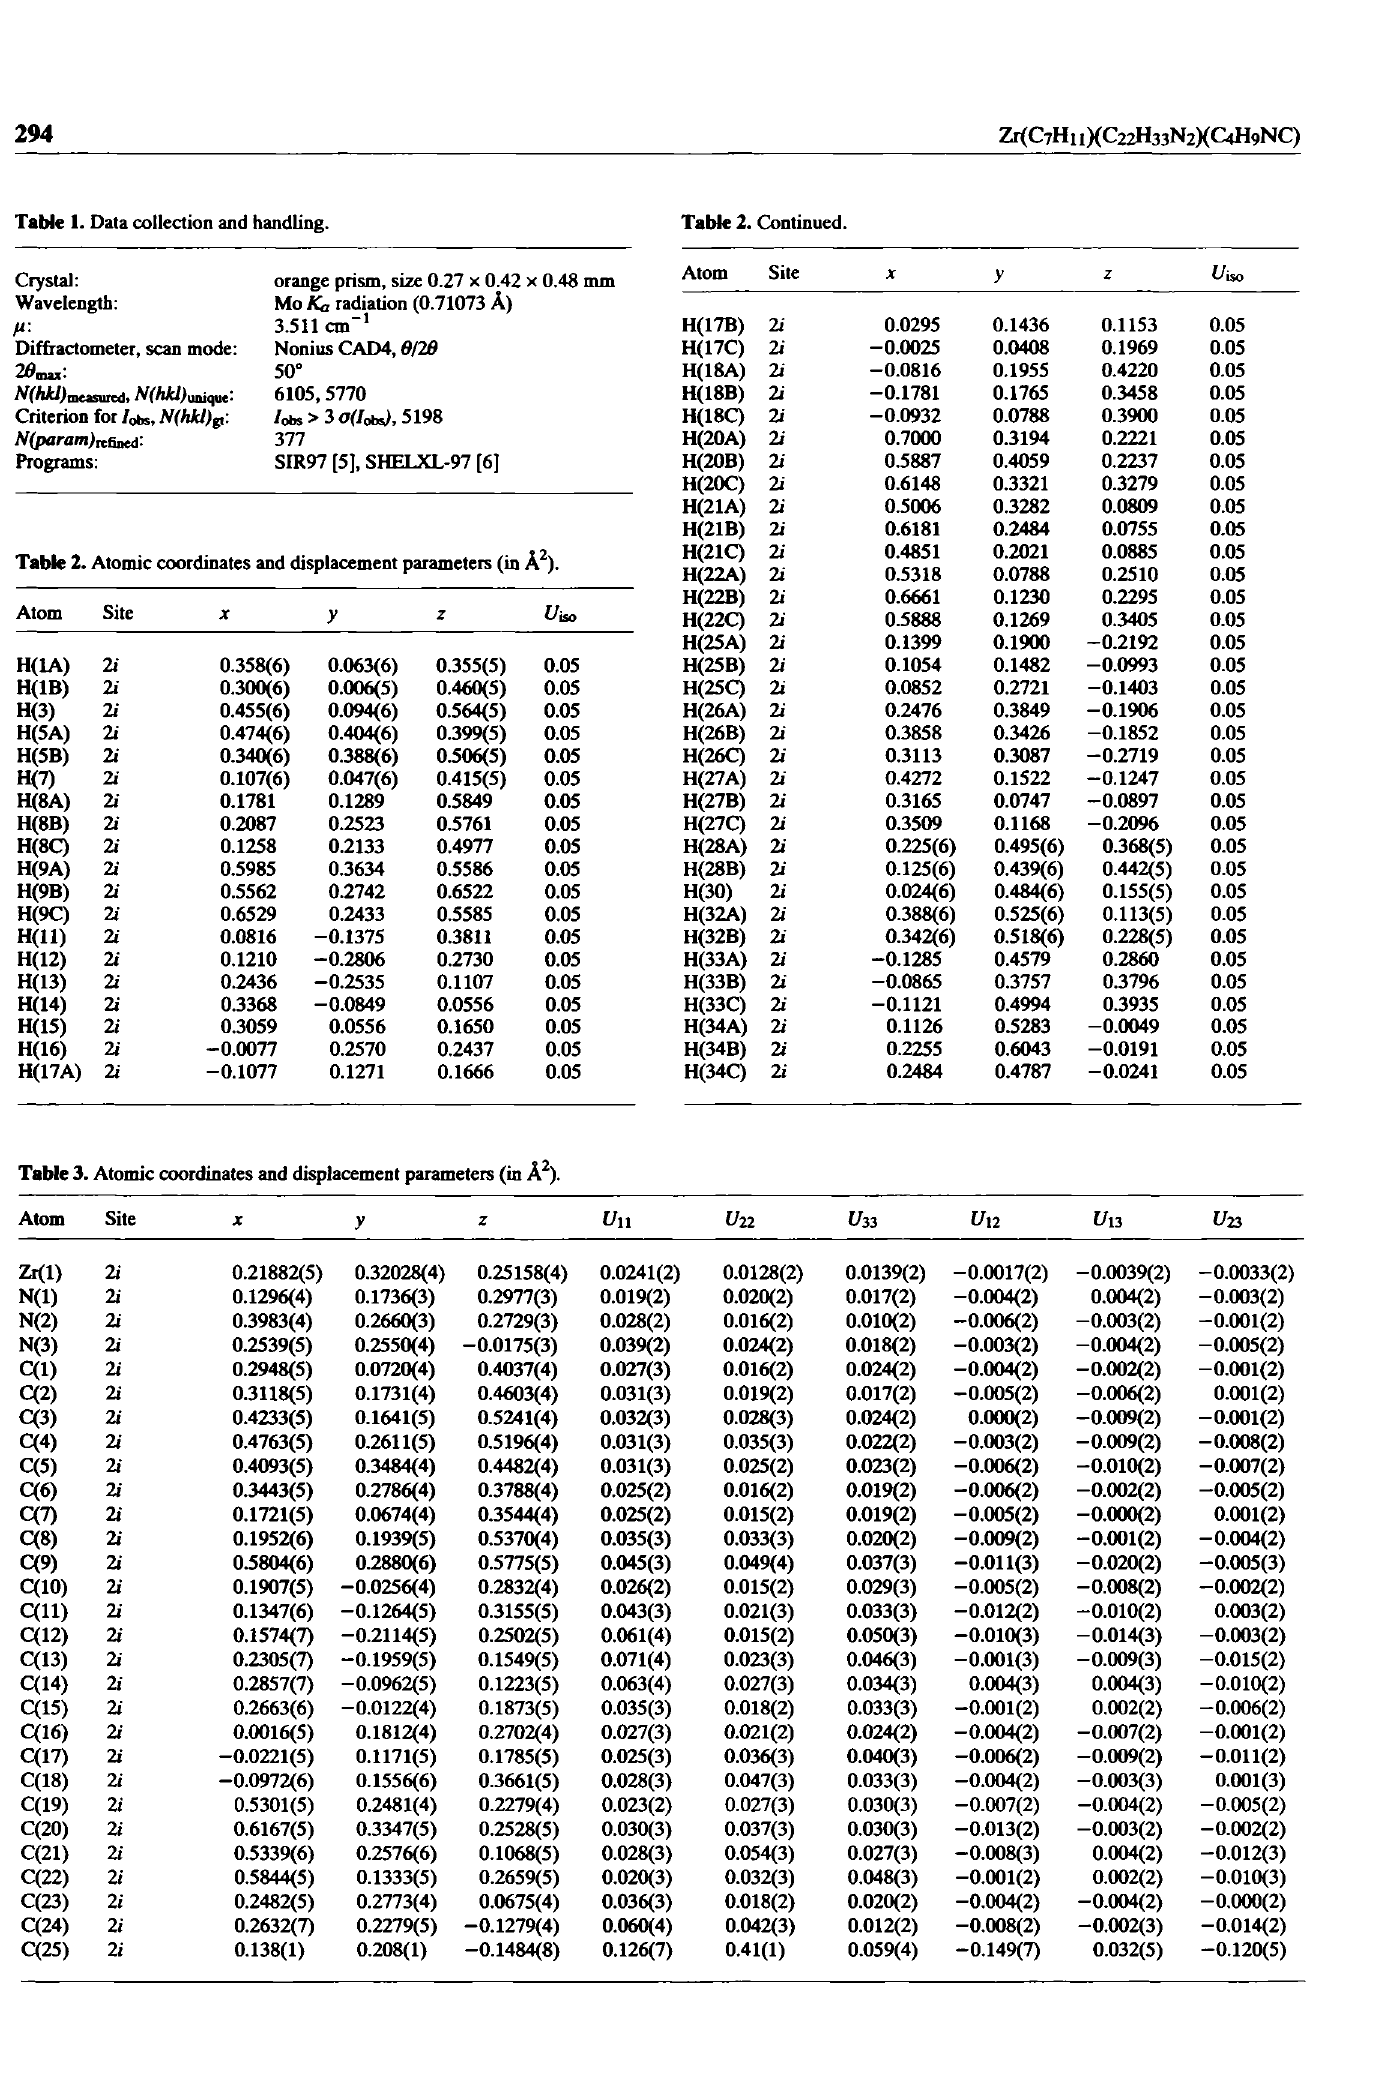
Table 3. Atomic coordinates and displacement parameters (in A 2